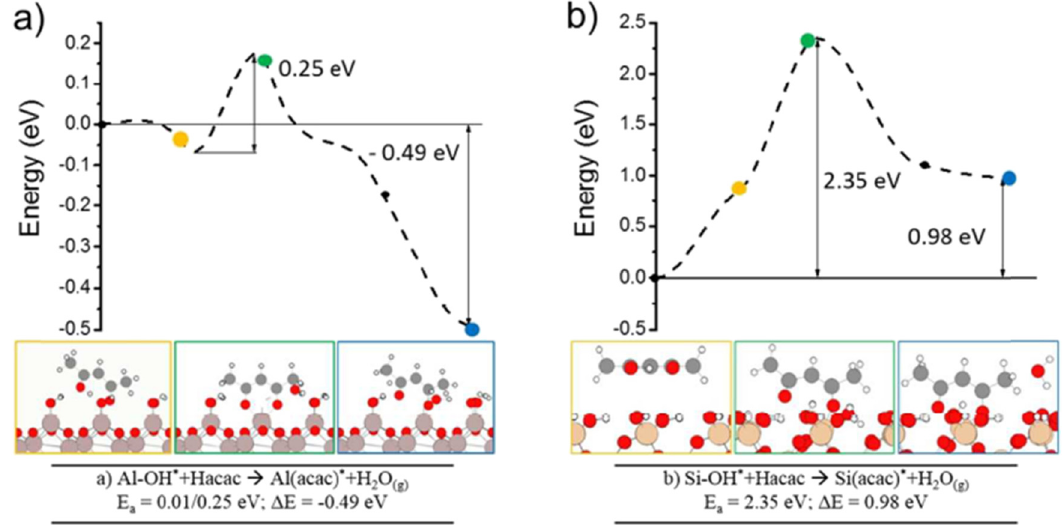
Figure 5: Density functional theory ( GGA/PBE - D3 ) [ 96 ] of minimum energy paths ( MEPs ) needed to adsorb Hacac on ( a ) aluminium oxide ( Al ) and ( b ) silicon dioxide ( SiO ) surfaces [ 52 ] 2 O 3 2